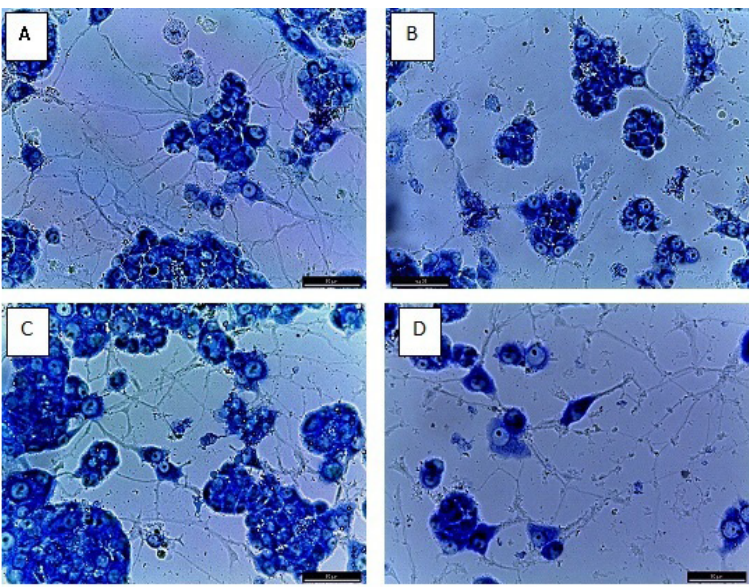
FIGURE 2 - Microscopic images of dPC12 cells with the G. corniculatum extracts and H Control (untreated dPC12 cells), B: H water extract pre-treated